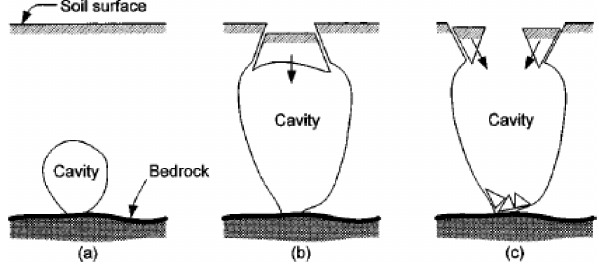
Figure 1. Conceptual model of cavity propagation (Augarde et al.,